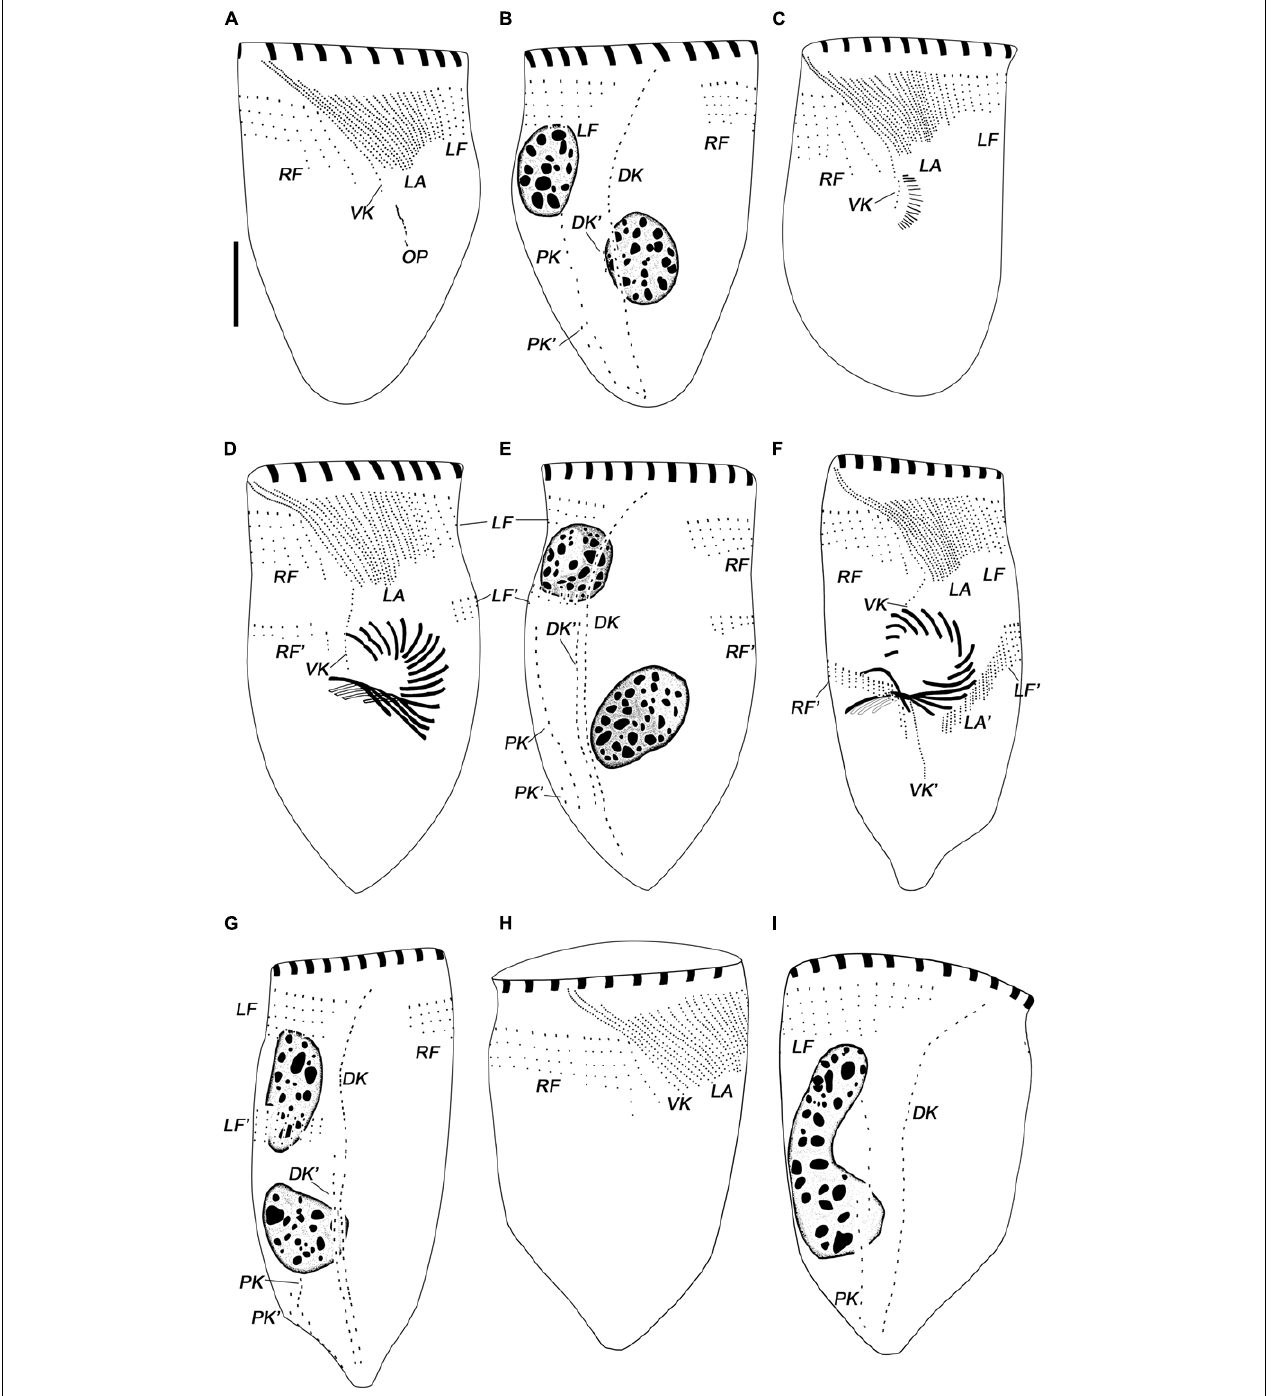
FIGURE 4 | Leprotintinnus nordqvisti , dividers after protargol staining. (A,B) Ventral and dorsal views of the same very early divider. (C) Ventral views of an early divider. (D,E) Ventral and dorsal views of the same late middle divider. (F,G) Ventral and dorsal views of the same middle-to-late divider. (H,I) Ventral and dorsal views of a new cell. DK, DK (cid:48) , proter’s and opisthe’s dorsal kineties; LA, LA (cid:48) , proter’s and opisthe’s lateral ciliary fields; LF, LF (cid:48) , proter’s and opisthe’s left ciliary fields; OP, oral primordium; RF, RF (cid:48) , proter’s and opisthe’s right ciliary fields; VK, VK (cid:48) , proter’s and opisthe’s ventral kineties. Scale bars: 20 µ m.